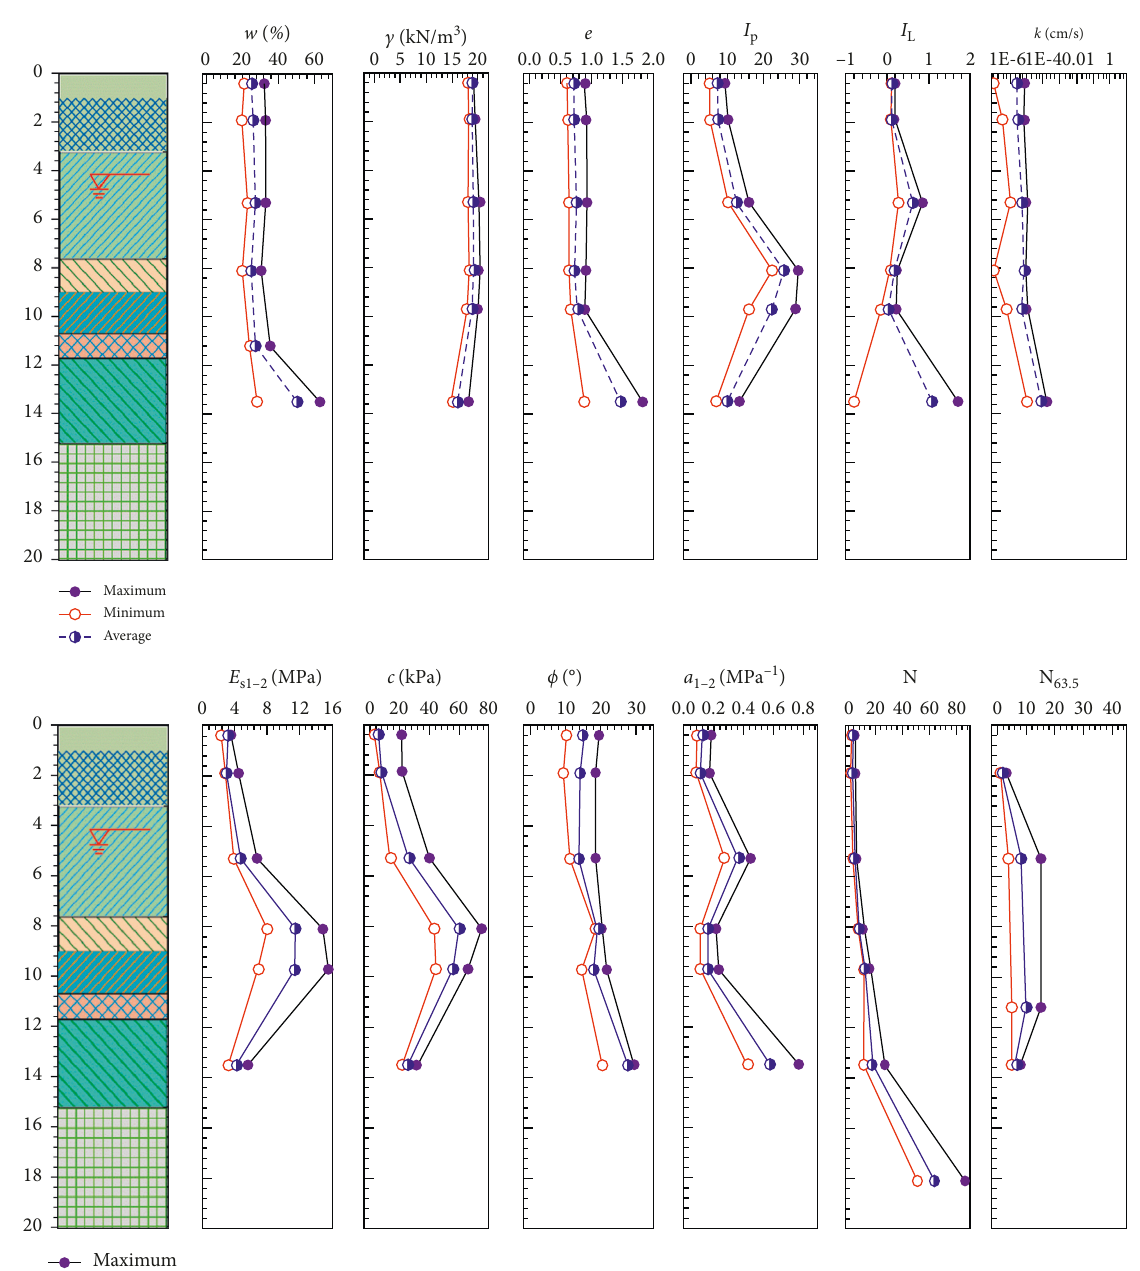
Figure 6: Soil profiles and geotechnical